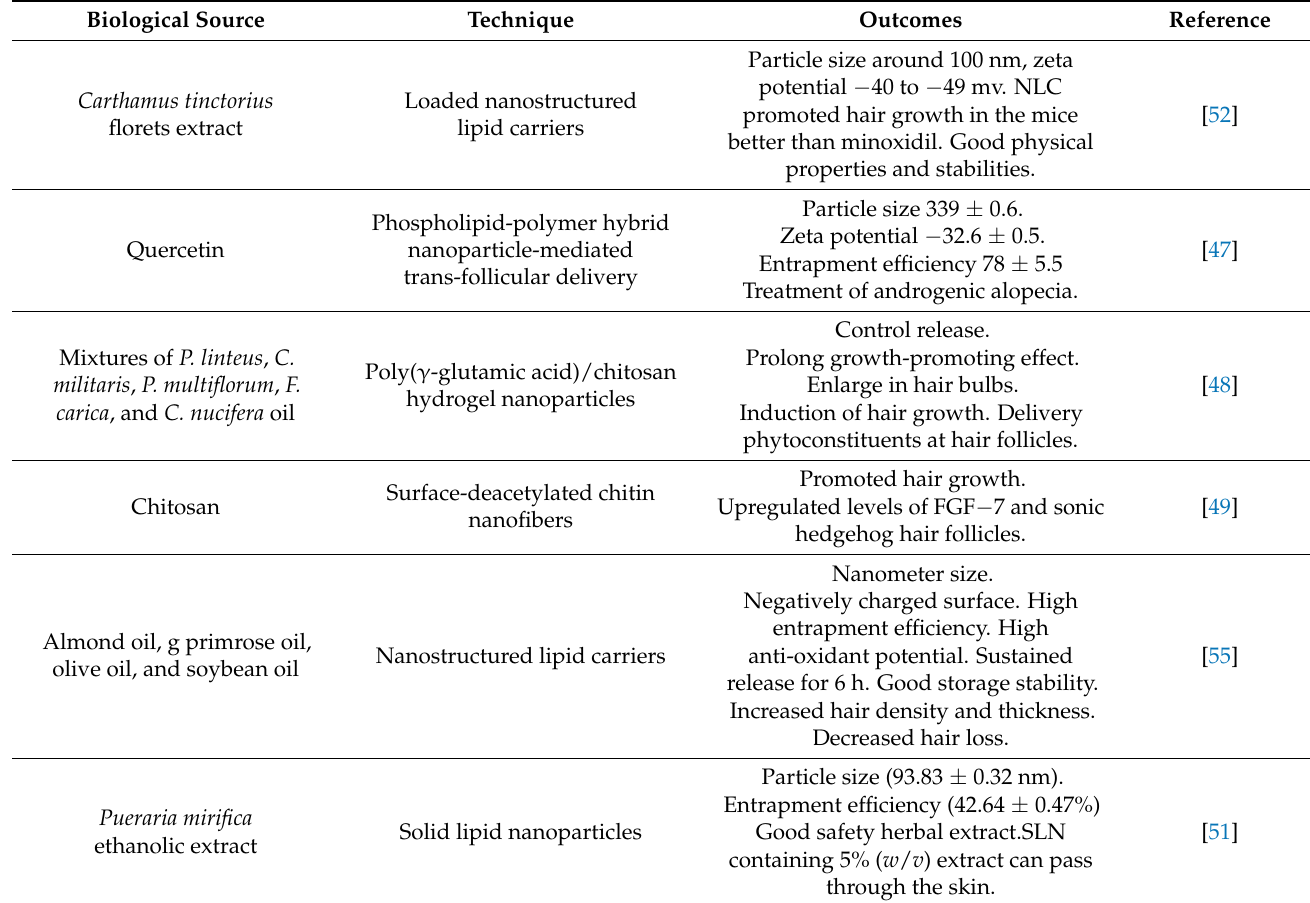
Table 1. Nano-formulation for herbal